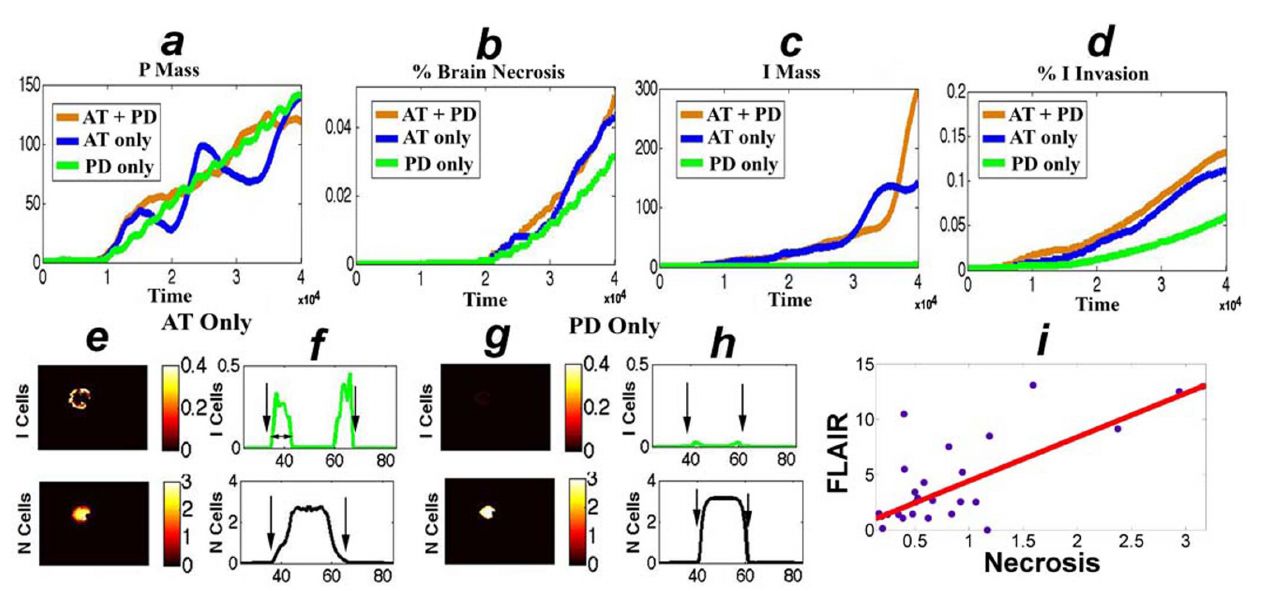
Fig. 3. AT enhances both necrosis and invasion. The first row compares the effects of AT only (blue), PD only (green), and AT + PD (orange) on the evolution of the proliferative tumor mass (a, P Mass), percent of the brain that is necrotic (b), invasive tumor mass (c, I Mass), and percent brain invasion by I cells (d) for the Full model. (e) and (g) show the 2-dimensional distribution of I cells and N at the final steps of the ATonly and PD only models, respectively; (f) and (h) plot vertical one-dimensional sections. (i) plots the areas of necrosis vs (FLAIR signal - Tumor) ( mm 2 , see S2 Figure) of 26 newly-diagnosed GBMs. The data is fitted to the polynomial f ( x ) ~ 3 : 965 x z 0 : 4502 by the robust least square method (least absolute residuals, R-square: 0 : 9405 ). Units are arbitrary.